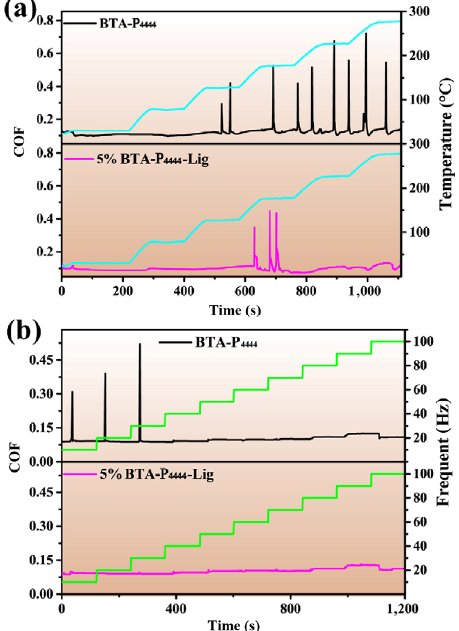
Fig. 8 (a) Effect of changing temperature on the COFs of BTA-P 4444 and 5% BTA-P 4444 -Lig lubricating materials and (b) influence of changing frequency on the COFs of BTA-P 4444 and 5% BTA-P 4444 -Lig lubricating materials.